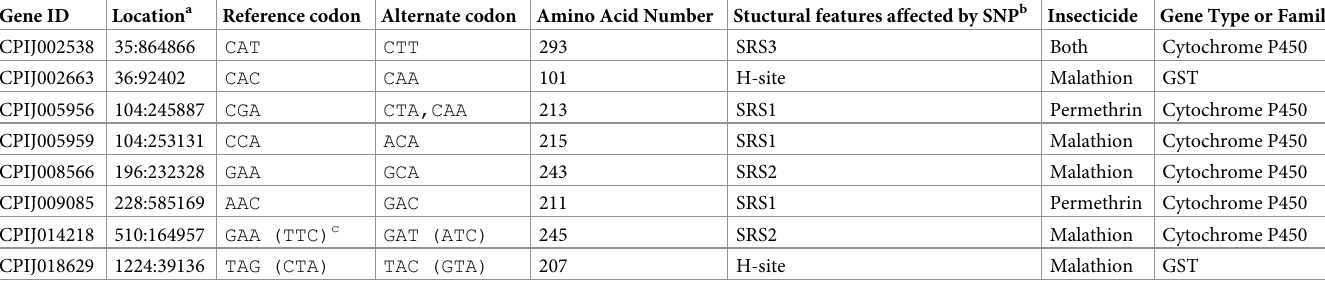
Table 5. Nonsynonymous SNPs located in positions that contribute to secondary structure of the protein. Gene ID Location a